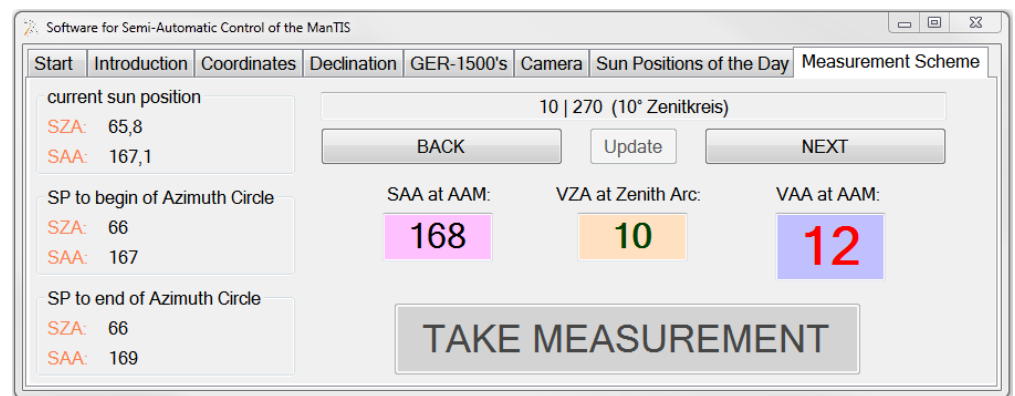
Figure 4. Graphical user interface (GUI) of the software application for the semi-automatic control of the ManTIS field